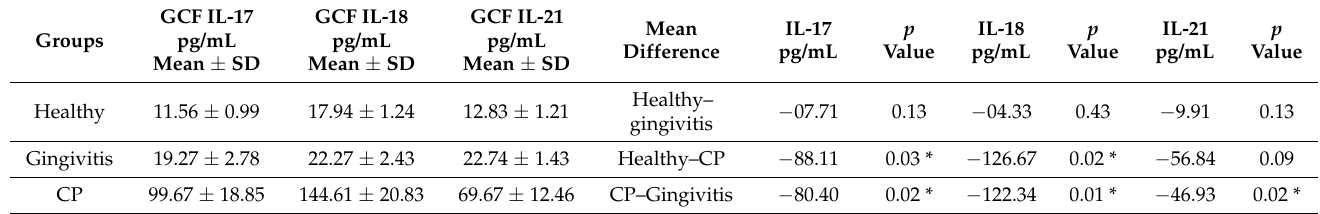
Table 2. Intergroup comparisons of the interleukin levels by post hoc Tukey’s test.